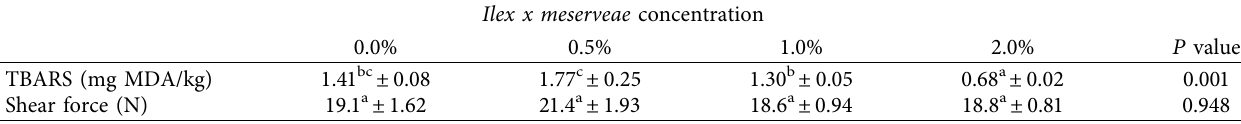
Table 1: Effect of Ilex meserveae on TBARS and shear force value of dry-aged beef.